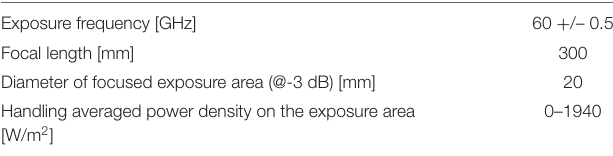
TABLE 1 | Specifications for developed exposure setup. Exposure frequency [GHz] 60 + /–